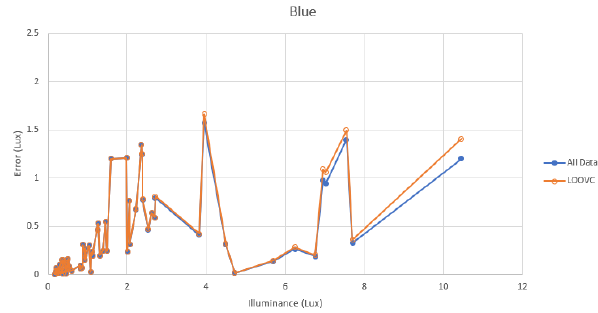
Figure 14. Absolute residual plot from all data and LOOVC of regression model of blue.